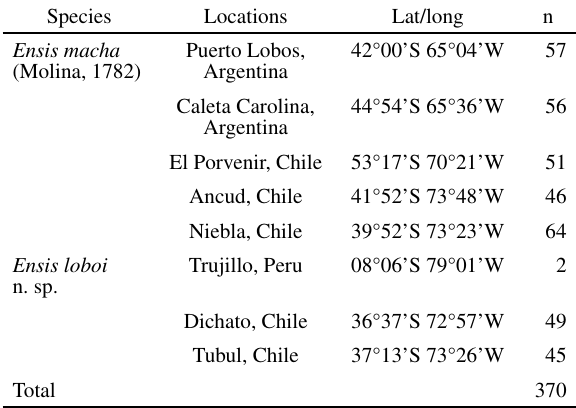
Table 1. – Sampling